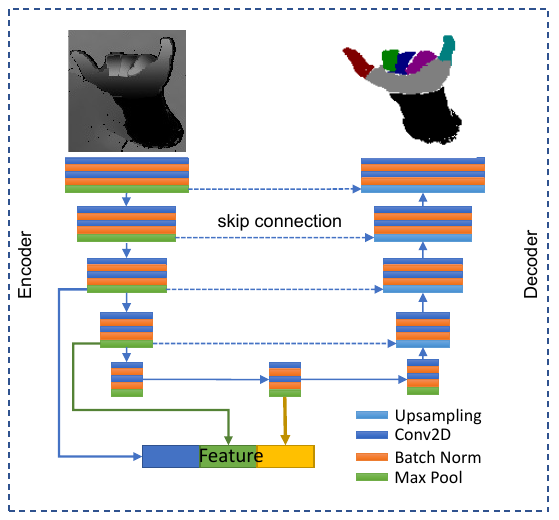
Figure 6. Hand component segmentation model to extract depth shape